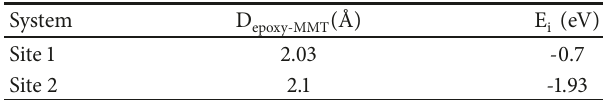
Table 1: Interaction energy and the equilibrium distances between the closest atom of the epoxy and the layer of